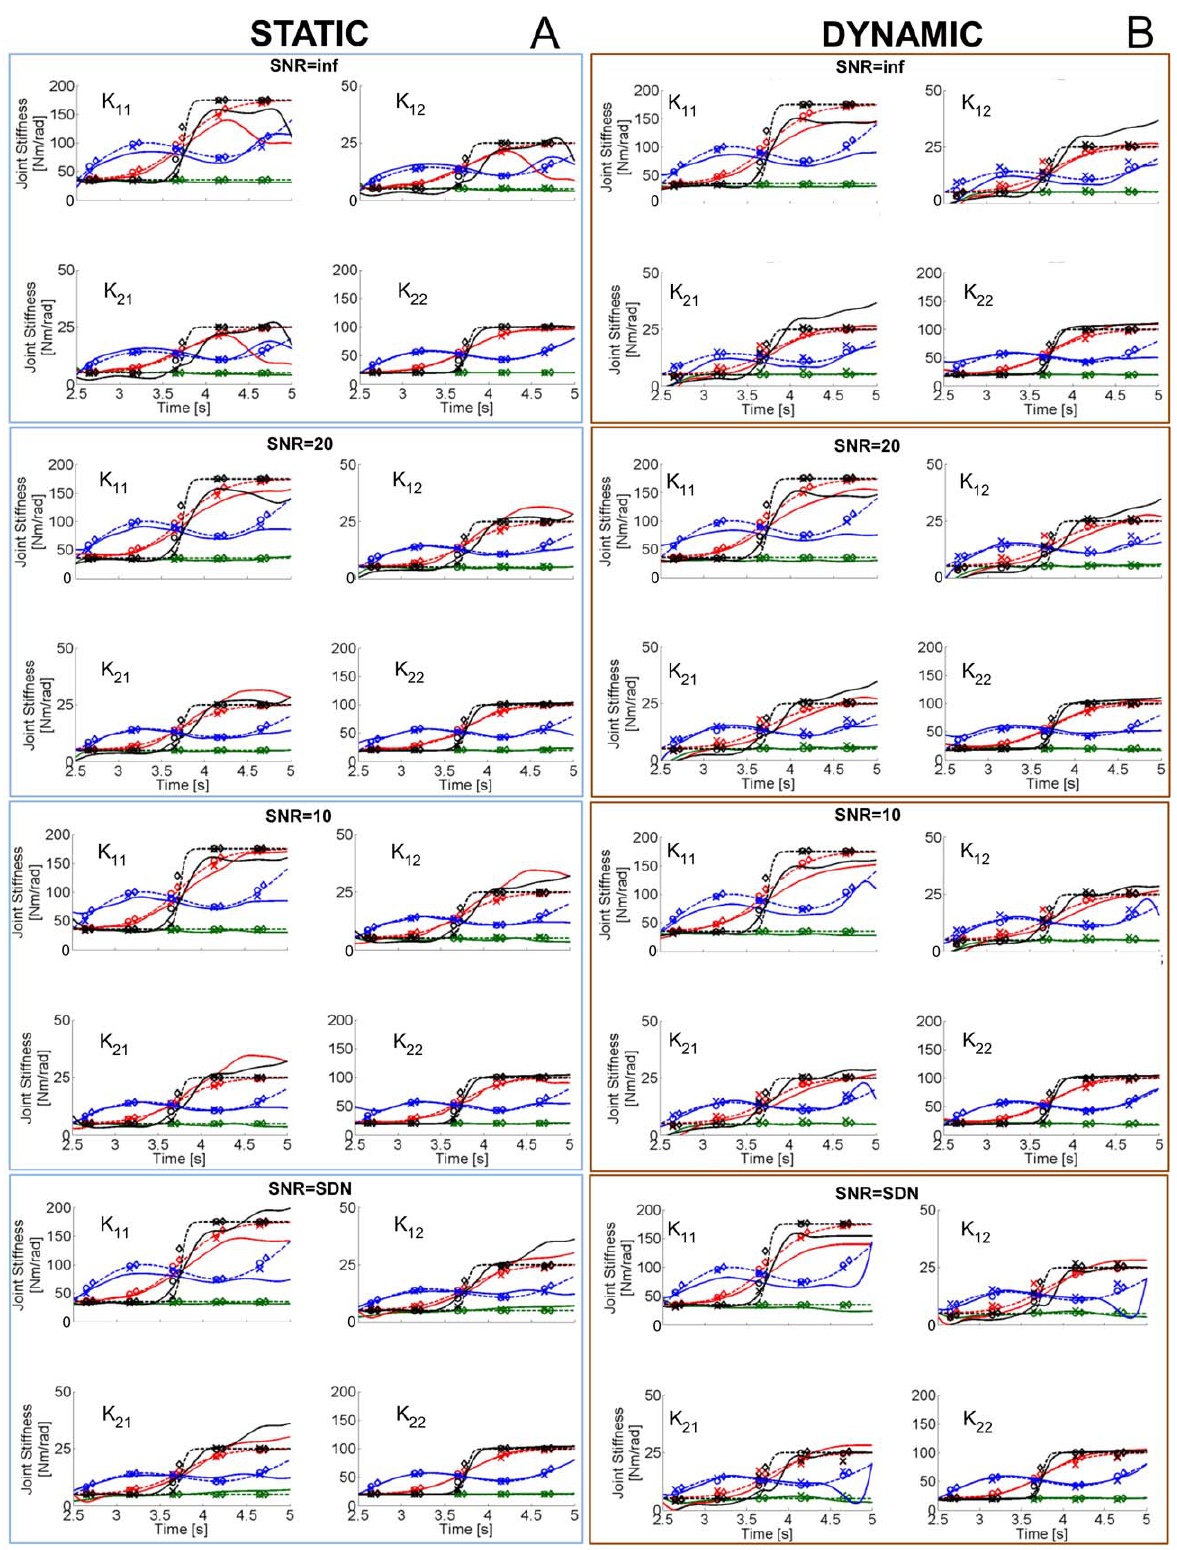
Figure 7. Stiffness estimation comparisons. A) Each graph represents the temporal variation of a specific component of the stiffness matrix as depicted in Figure 3. The hand is in a static posture at position (0.4,0) as represented in Figure 1. A ‘‘sinlin’’ damping profile is imposed and four profiles of stiffness are presented: constant (green), sigmoidal (red), sinlin (blue), sharp (black). Dashed stiffness profiles are those imposed in the simulation, while the solid-line profiles are the estimations obtained with the proposed spectrographic method. ‘‘X’’ represents the estimations of stiffness using a ‘‘full regression’’ from an imposed displacement. Each point represents the average stiffness within a 200 ms window.’’ e ’’ refers to